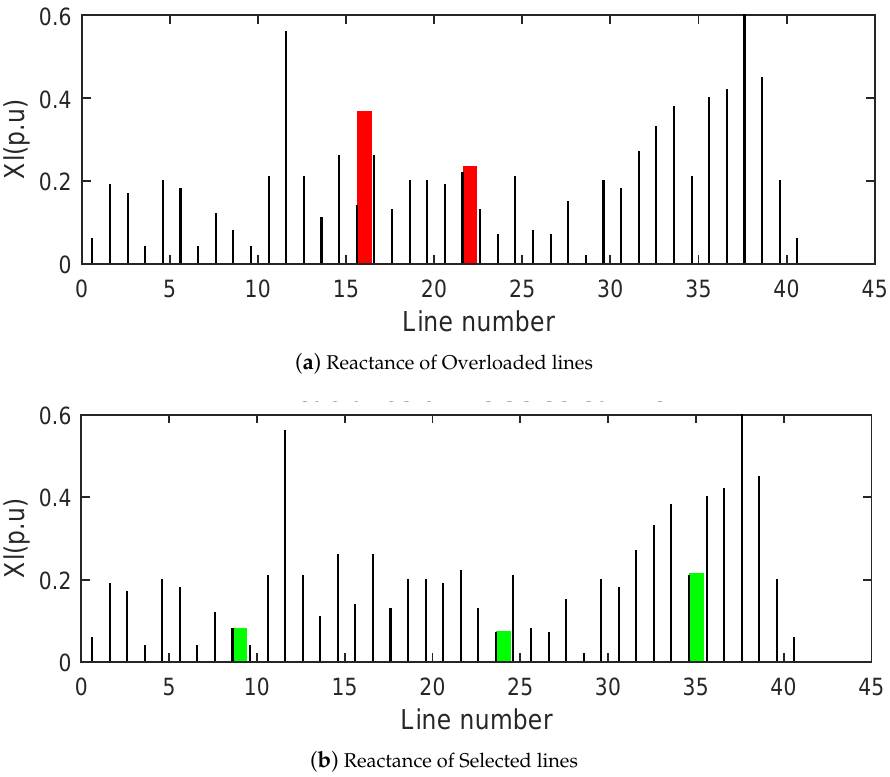
Figure 6. Reactance variation of lines in IEEE 30 bus system.